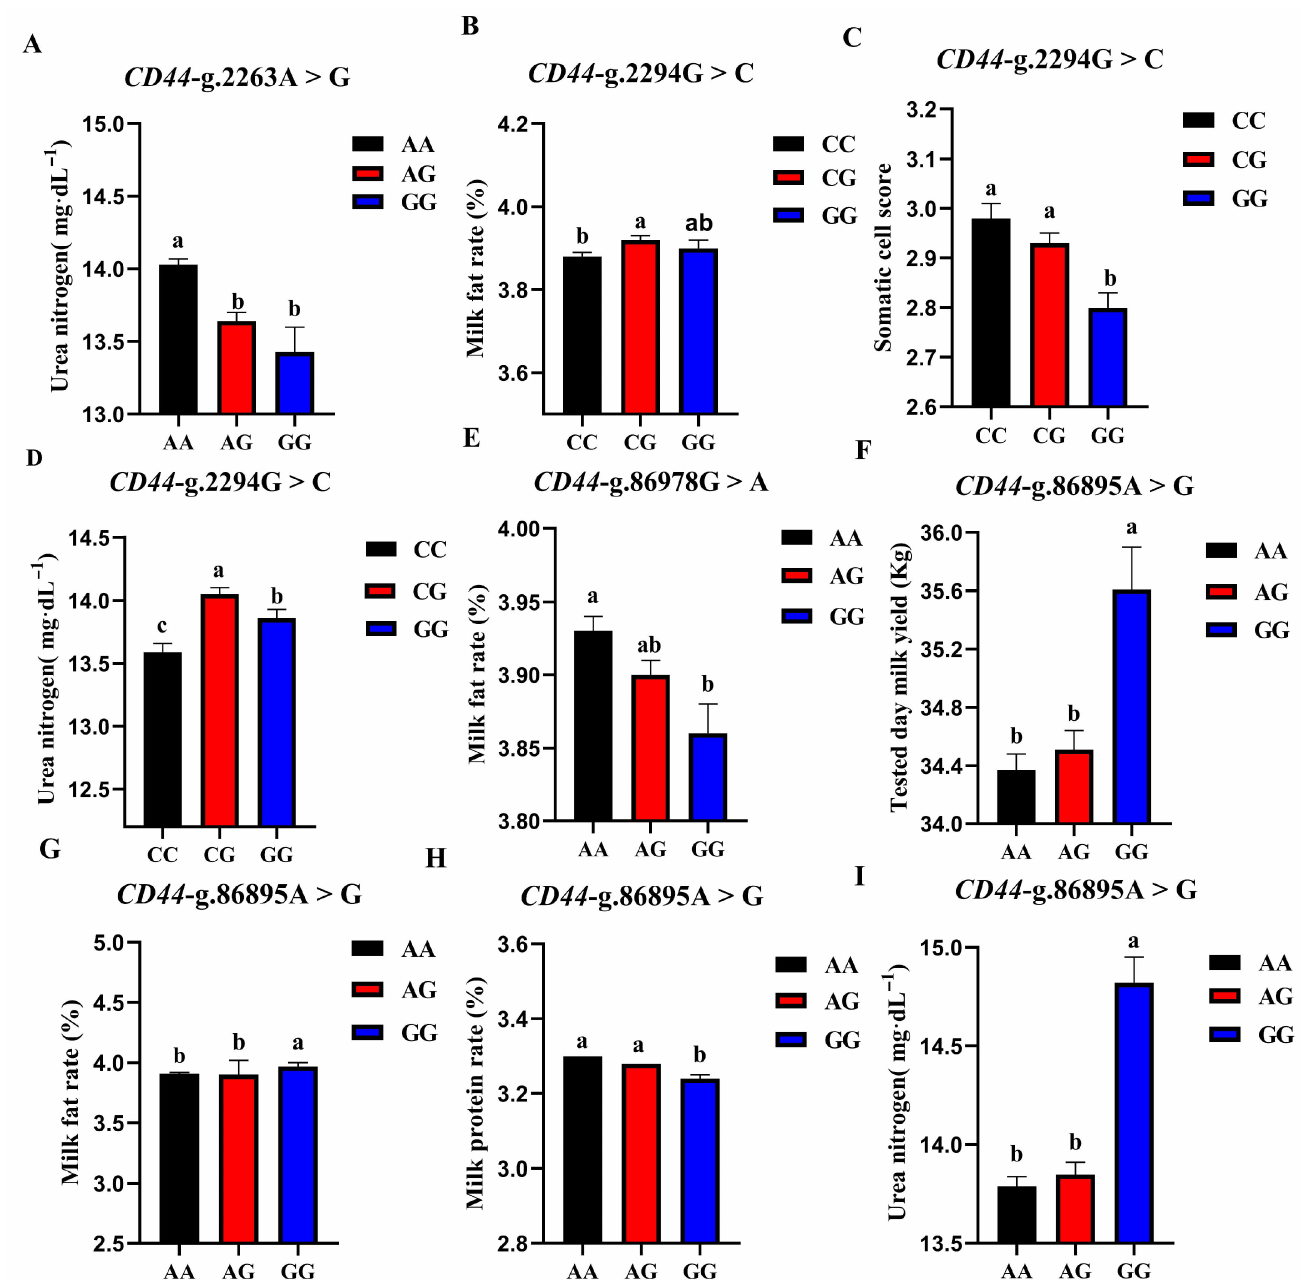
Figure 7. Effect of different genotypes in CD44 four SNP loci on production traits in Chinese Holstein cattle. In CD44 -g.2263A > G locus, AA type urea nitrogen content of was significantly higher than that of AG and GG genotypes ( A ). In CD44 -g.2294G > C locus, milk fat percentage ( B ) and milk urea nitrogen content of CG-type ( D ) cows were significantly higher than CC and CG types. Higher SCS for CC- and CG-type cows ( C ). In CD44 -g.86978G > A locus, Type AA cows have the highest milk fat percentage ( E ). In CD44 -g.86895A > G locus, tested day milk yield ( F ), milk fat rate ( G ), and milk urea nitrogen content ( I ) of GG-type cows were significantly higher than those of AA, AG types; AA and AG cows had the highest protein rates ( H ). Data in the same column with different lowercase letters on the shoulder indicate significant differences ( p <